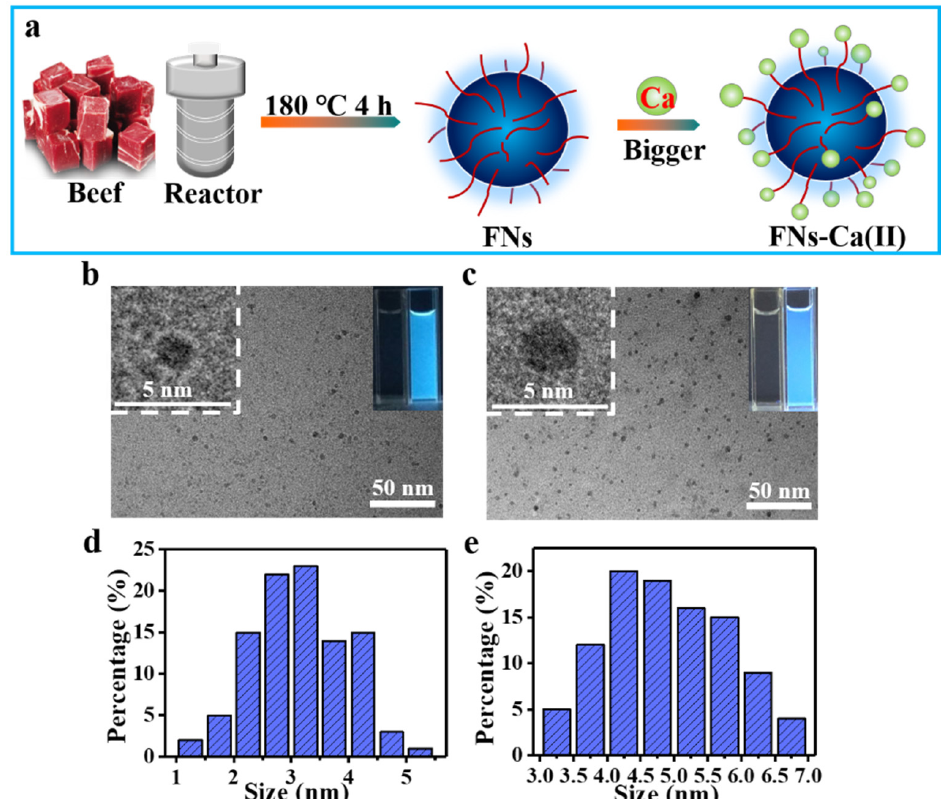
Figure 1. ( a ) Schematic illustration showing the beef FNs binding with calcium ions (FNs − Ca(II)). TEM images of FNs ( b ) and the FNs − Ca(II) complexes ( c ); insets represent high-resolution TEM TEM images of FNs ( b ) and the FNs-Ca(II) complexes ( c ); insets represent high-resolution TEM images and the fluorescent photographs of water (left) and FNs/FNs − Ca(II) (right) under a UV lamp. images and the fluorescent photographs of water (left) and FNs/FNs-Ca(II) (right) under a UV lamp. Size distribution histogram for FNs ( d ) and FNs − Ca(II) ( e ). Size distribution histogram for FNs ( d ) and FNs-Ca(II) ( e